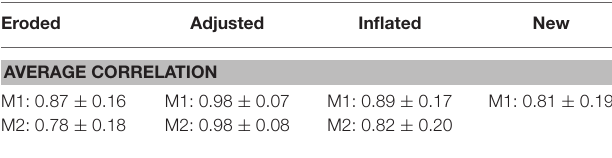
TABLE 3 | Average correlation of time-series identified from different masks with the original time-series. Eroded Adjusted Inflated New AVERAGE CORRELATION